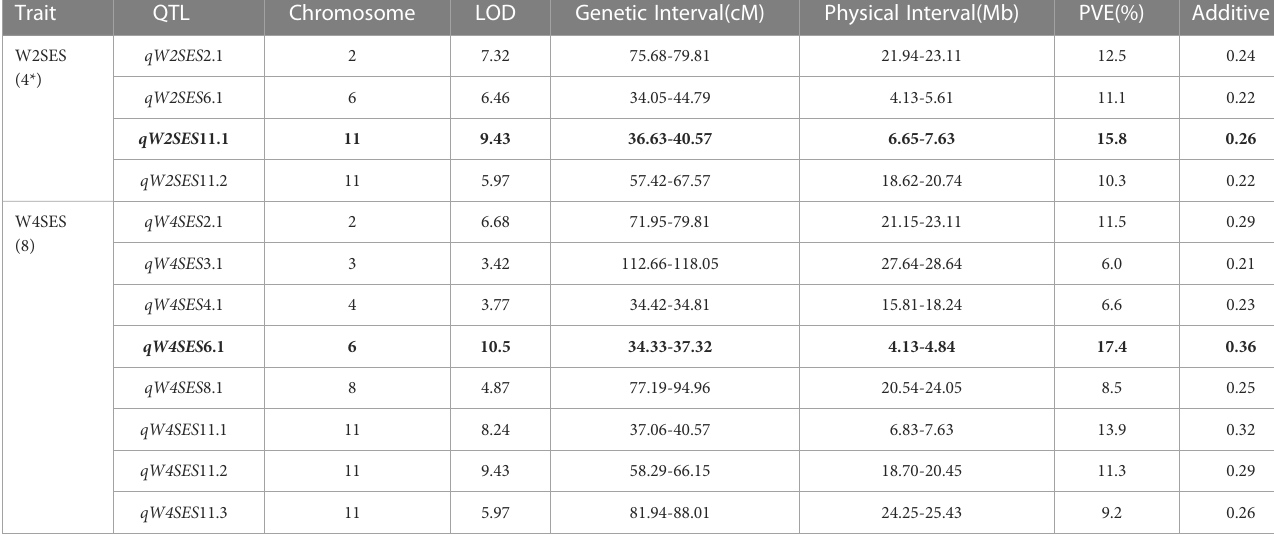
TABLE 3 QTL mapping of BLUP values of W2SES and W4SES. Trait QTL Chromosome LOD Genetic Interval(cM) Physical Interval(Mb)